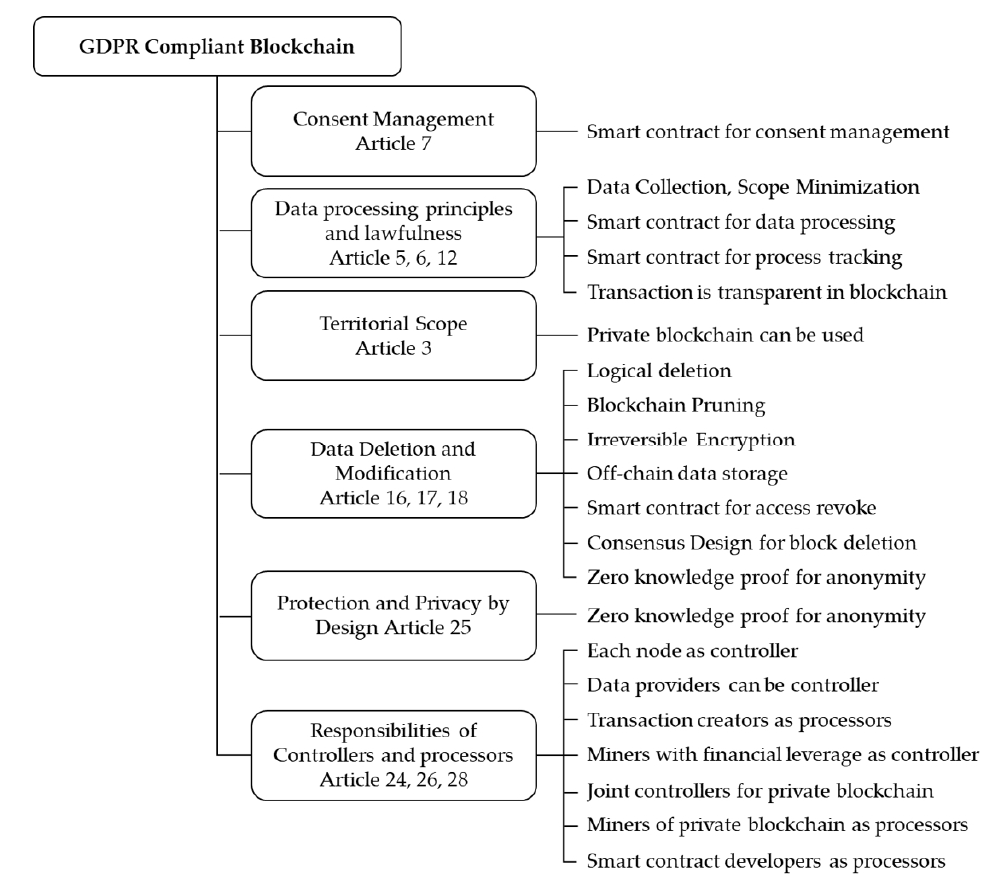
Figure 2. Proposed solutions for GDPR compliance.